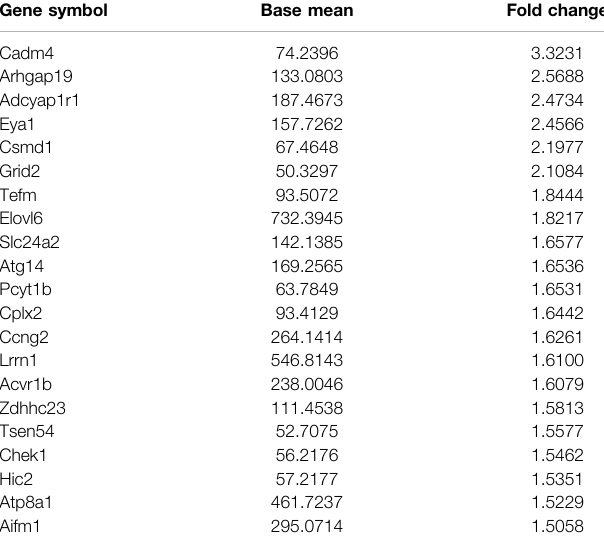
UpregulatedgenesinAchillestendonfrom Dicer cKOmousebyRNA-sequencingwhich are also predicted by TargetScan for target candidate genes of miR-135a. Differentially expressedgenes(1.5-folddifference)areshownastheratioof Dicer cKOtocontrolmice.